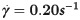
Biofilm deformation and detachment at γ˙=0.20s−1.(a) time, T** = 0; (b) T** = 8000; (c) T** = 20000; (d) T** = 70000; (e) T** = 130000. Streamer formation and detachment is evident at the later stages of the deformation.